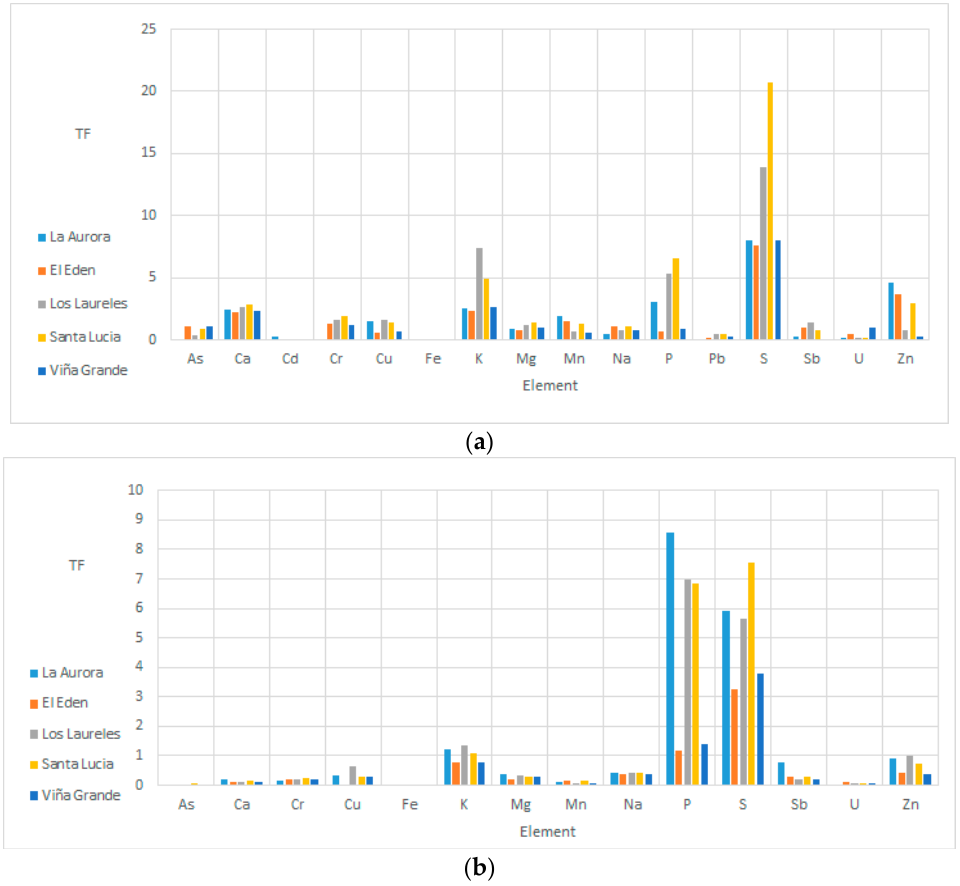
Figure 2. Transfer factors calculated: ( a ) from soil to leaves; and ( b ) from soil to walnut. The results for the TF of soil/leaves in walnuts indicates a high transfer of the nutrients Ca, Cu, K, Mg, Mn, P, S, and Zn. In the particular case of Cu, the TF ranges from 0.610 to 1.619. A study on spinach, cabbage, and celery leaves reported a mean TF of 0.02 [28]. The soil/leaves TF indicates a